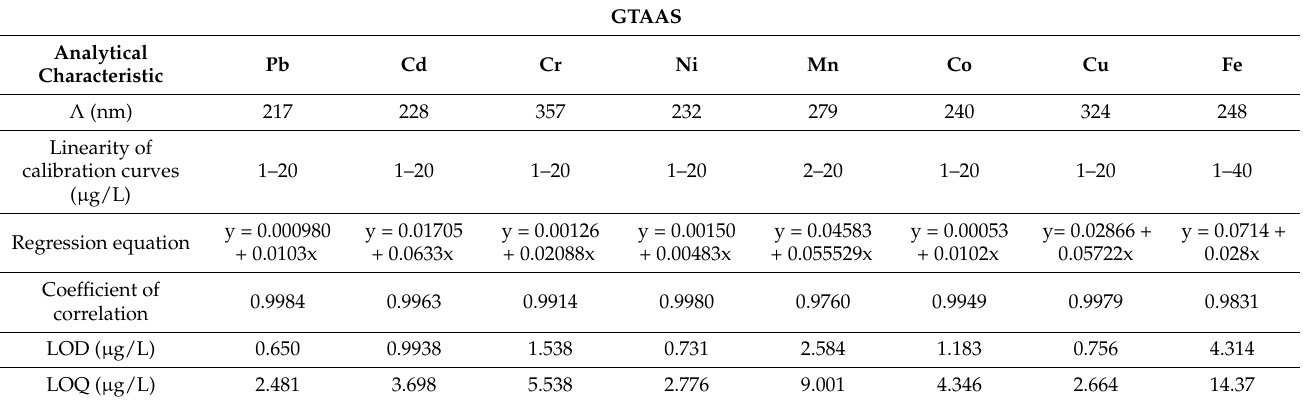
Table 1. Performance parameters of analytical method.